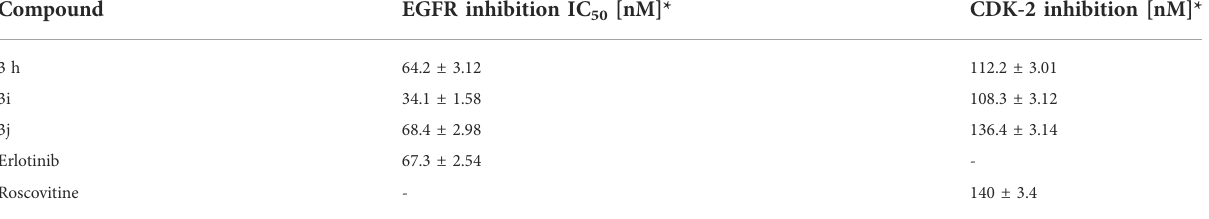
TABLE 3 IC 50 of the tested compounds against EGFR and